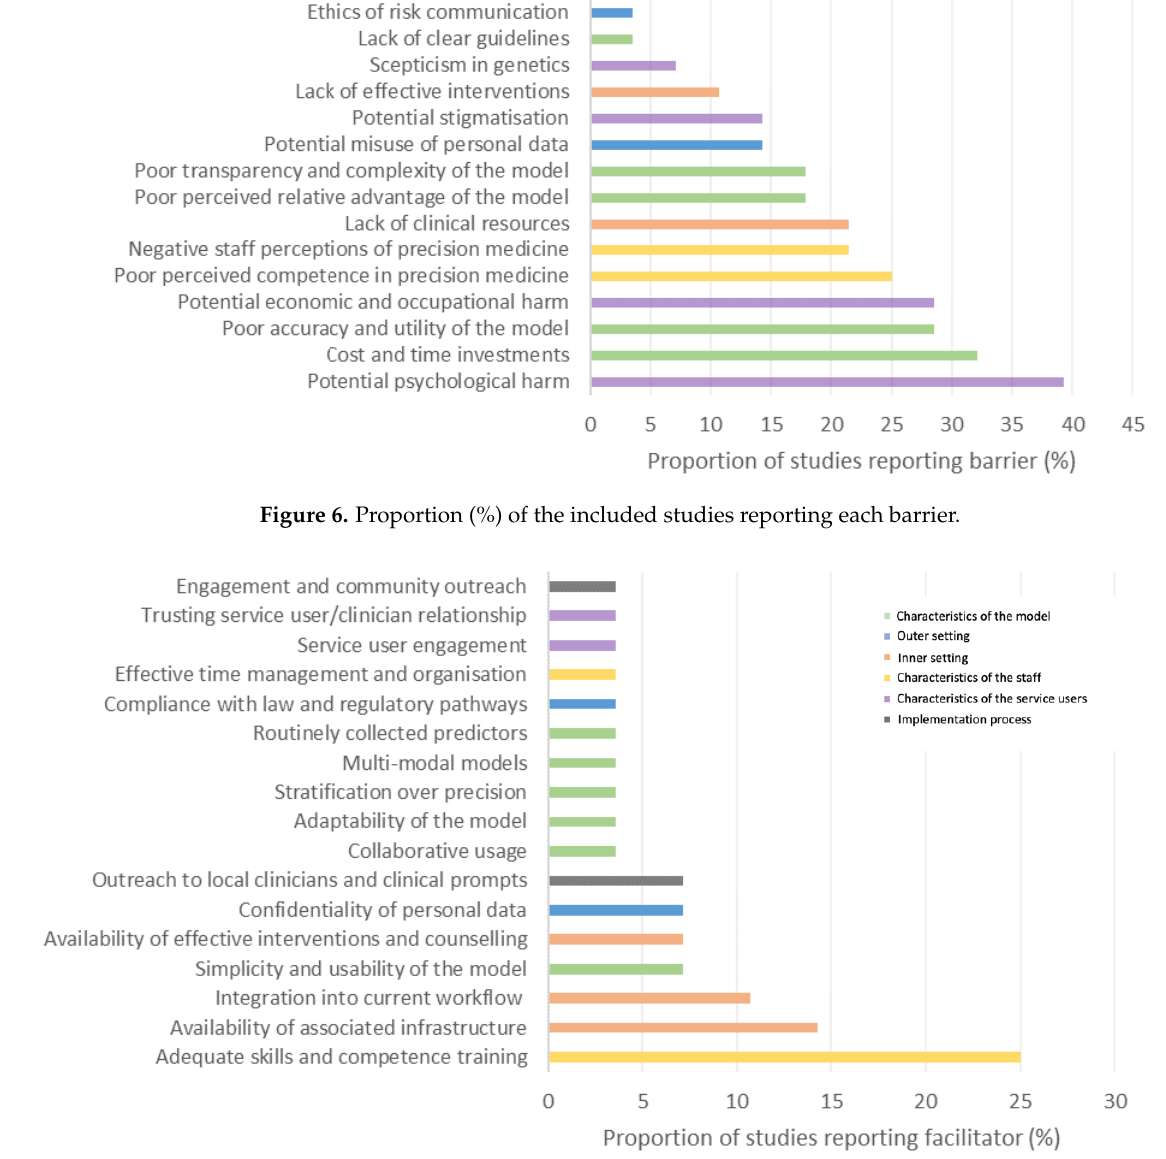
Figure 7. Proportion (%) of the included studies reporting each facilitator.